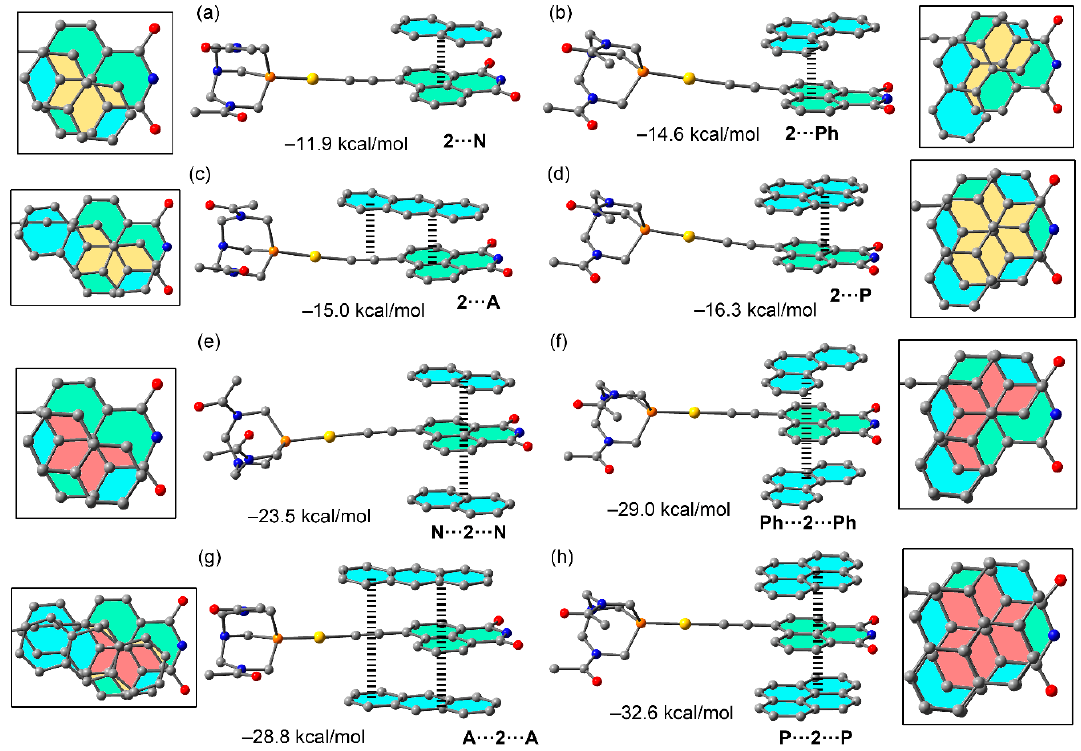
Figure 7. PB86-D3(COSMO)/def2-TZVP optimized geometries and binding energies of the dimers 2···N ( a ), 2···Ph ( b ), 2···A ( c ) 2···P ( d ) and trimers N···2···N ( e ), Ph···2···Ph ( f ), A···2···A ( g ) P···2···P ( h ).